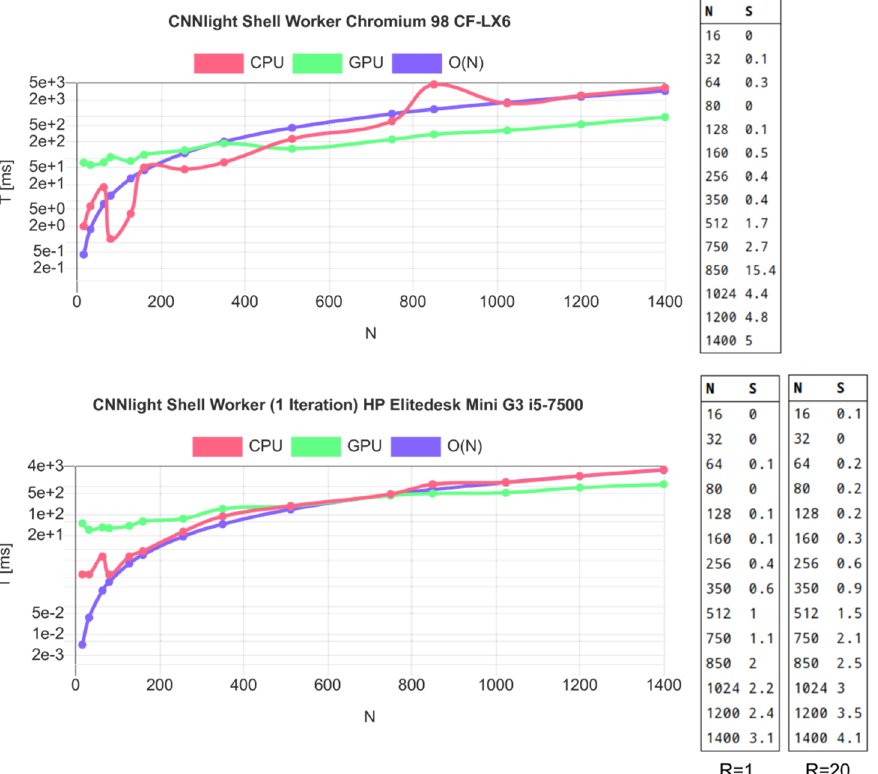
Figure 8. (Top) WorkBook worker/WebGL; (bottom) WorkShell worker/OpenGL: performance analysis of a data flow pipeline with 1 matrix kernel convolution, a fully connected perceptron layer merging the convoluted matrix with the application of a sigmoid function, and a second, fully connected perceptron layer (R: number of loop iterations).